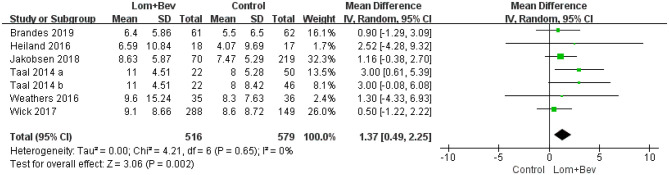
Forest plot of OS in glioblastoma between lomustine plus bevacizumab and control groups. OS, overall survival; Lom, lomustine; Bev, bevacizumab.